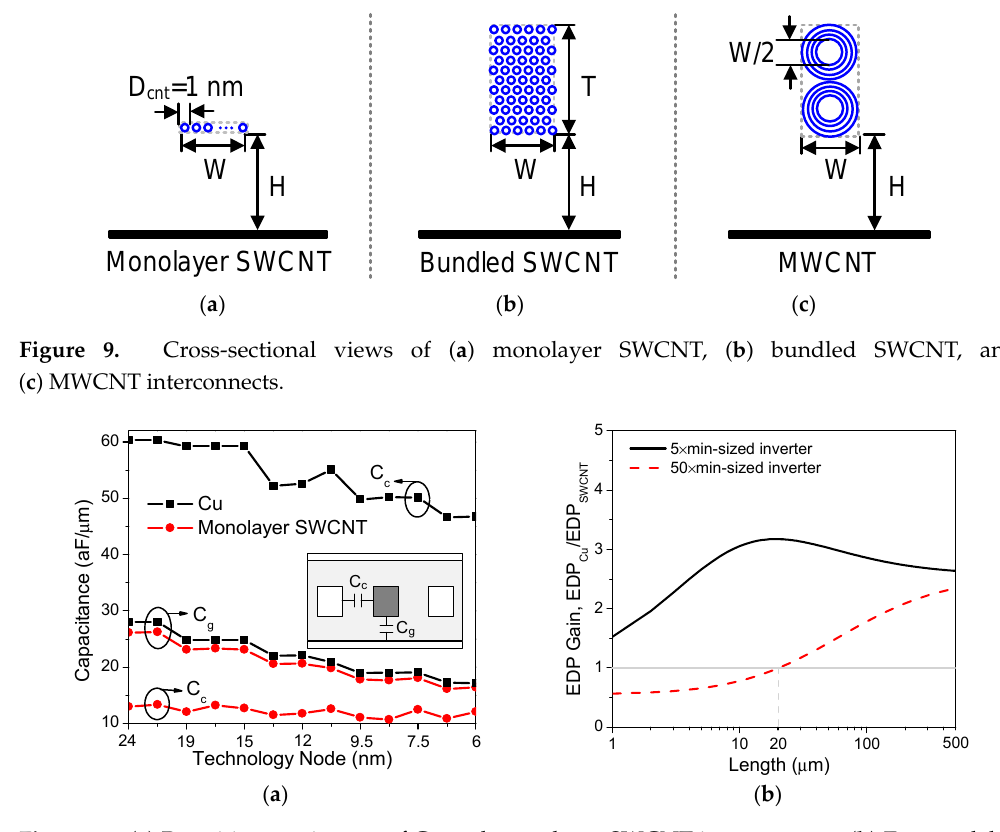
Figure 10. ( a ) Parasitic capacitances of Cu and monolayer SWCNT interconnects. ( b ) Energy-delay product ratio between Cu and monolayer SWCNT interconnects at the 19 nm technology node [60].